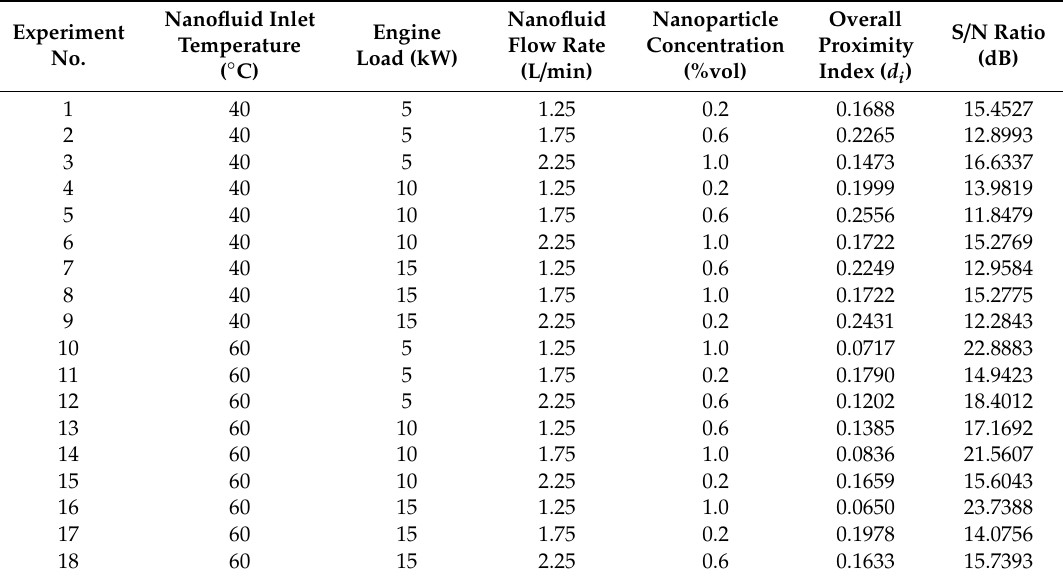
Table 10. Overall proximity index value and corresponding S / N ratio.